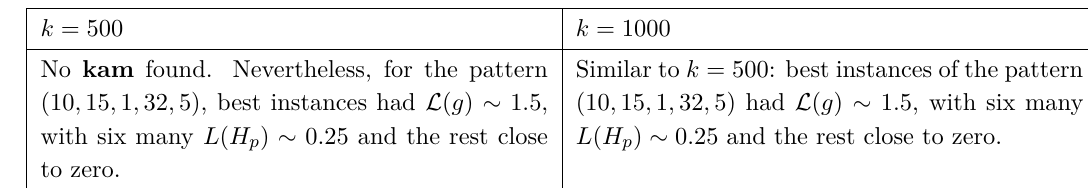
Table 4 . Kam ness for L 26 on su (8)